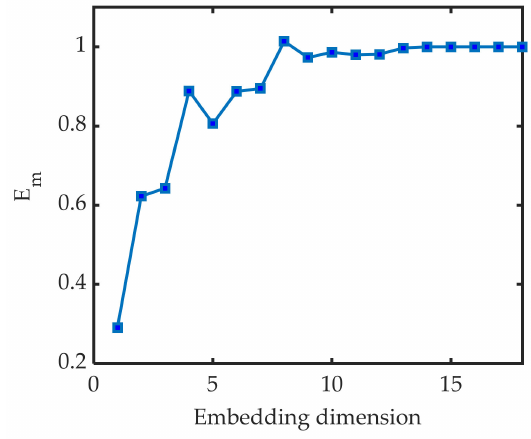
Figure 3. Using CAO method to find the embedding